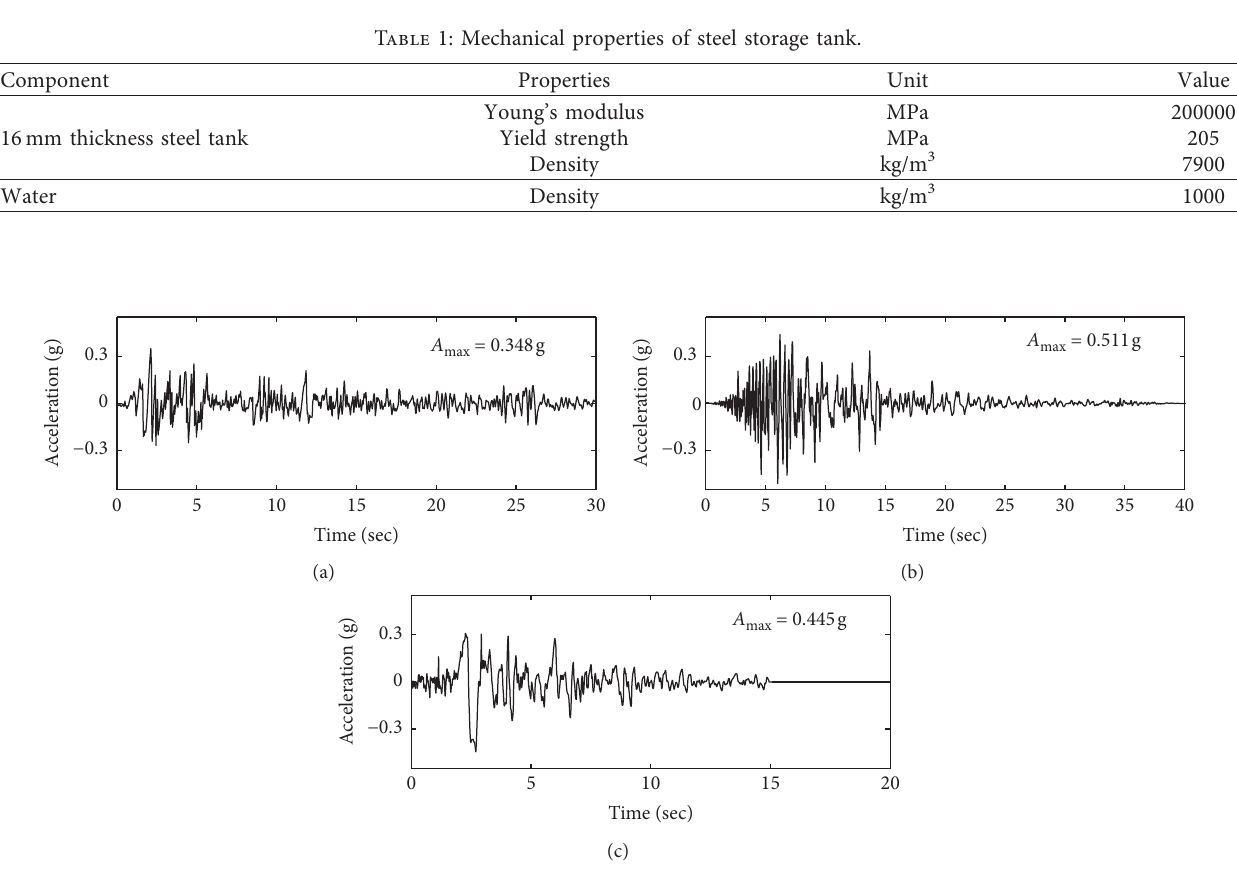
Figure 2: Various earthquake ground motions: (a) El Centro station record of 1940 Imperial Valley earthquake; (b) Capitola station record of 1989 Loma Prieta earthquake; (c) Rinaldi Receiving station record of 1994 Northridge earthquake.